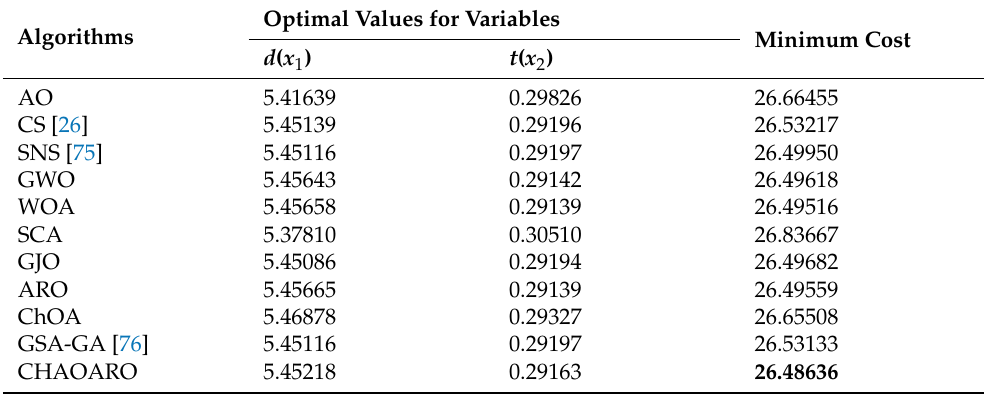
Table 14. Comparison results for tubular column design problem.